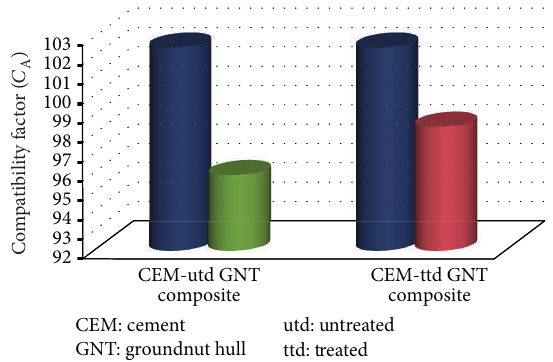
F 1: Effect of storage on compatibility factors of untreated and hot-water-treated samples with